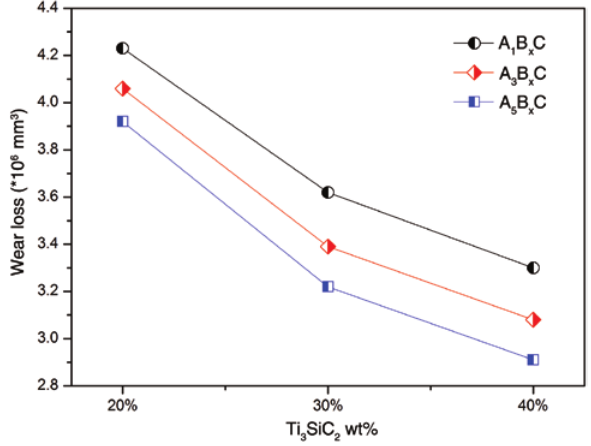
Figure 10: Wear loss of hybrid reinforced copper-matrix composite pantograph under carrier